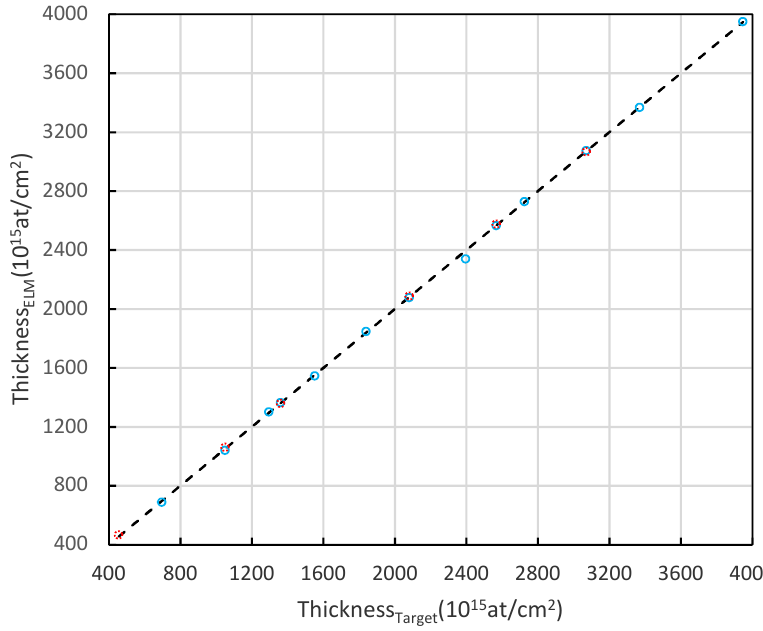
Figure 5. The ELM predicted thickness vs. exact target values.